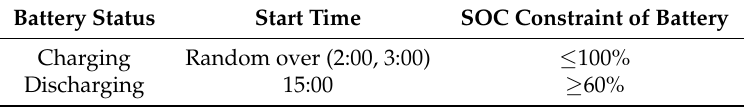
Table 6. Schedule of EV charging and discharging.